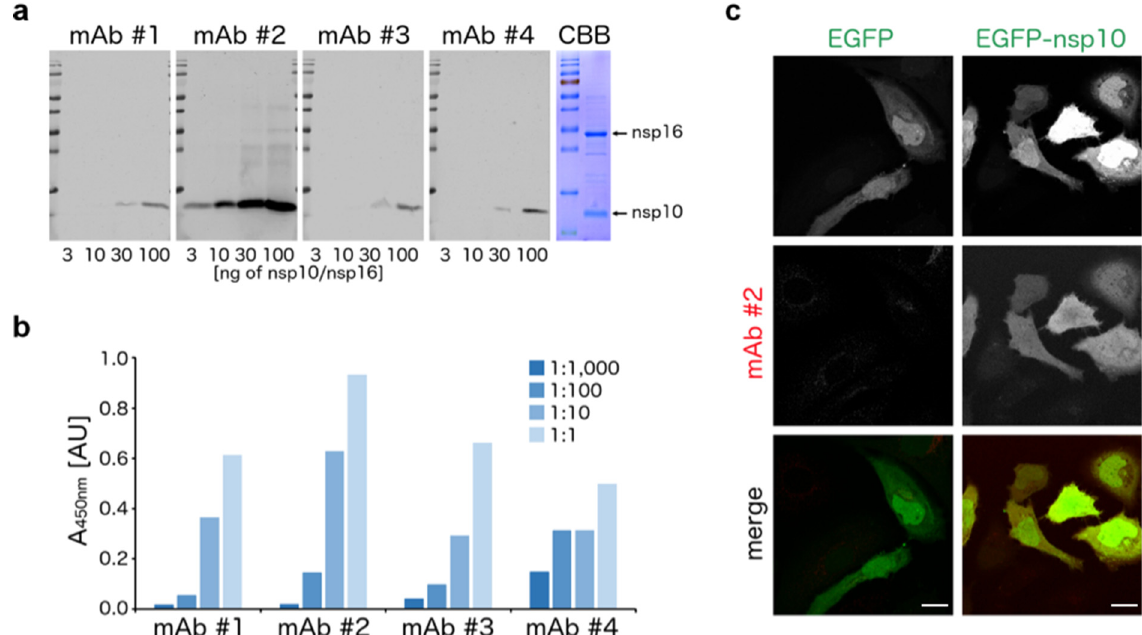
Figure 1. Specific interaction of the anti-nsp10 monoclonal antibody with both denatured and native nsp10 protein. ( a ) Indicated amounts of the recombinant SARS-CoV-2 nsp10/nsp16 complex were visualized either by SDS-PAGE coupled with Coomassie Brilliant Blue (CBB) staining, or by Western blotting coupled with immunostaining with supernatants from four candidate anti-nsp10/nsp16 antibodies-producing hybridomas. ( b ) Recombinant SARS-CoV-2 nsp10 protein was measured by the enzyme-linked immunosorbent assay (ELISA) using the indicated series of dilutions of supernatants from four candidate anti-nsp10/nsp16 antibodies-producing hybridomas. ( c ) EGFP-fused SARS-CoV-2 nsp10 protein or EGFP alone as a control were overexpressed in HeLa cells by transient transfection. The cells were fixed and immunostained with the supernatant from the selected hybridoma. Expression of nsp10 (red) and EGFP (green) was analyzed by confocal microscopy. Scale bars represent 20 µ